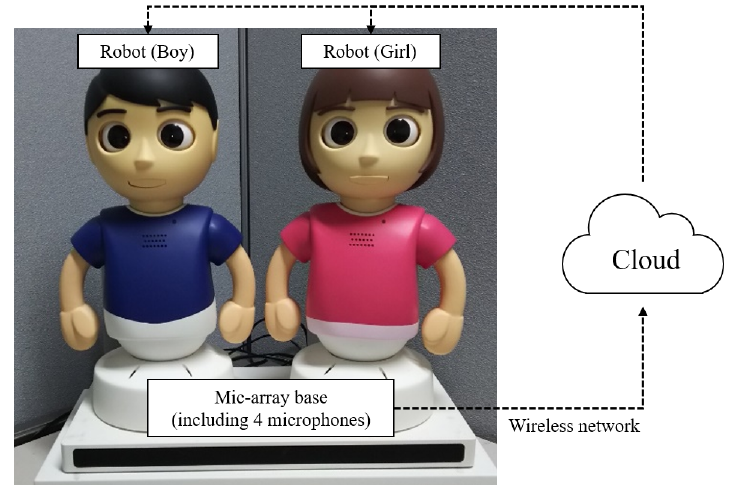
Figure 3. Hardware components of the system and the connections between them.